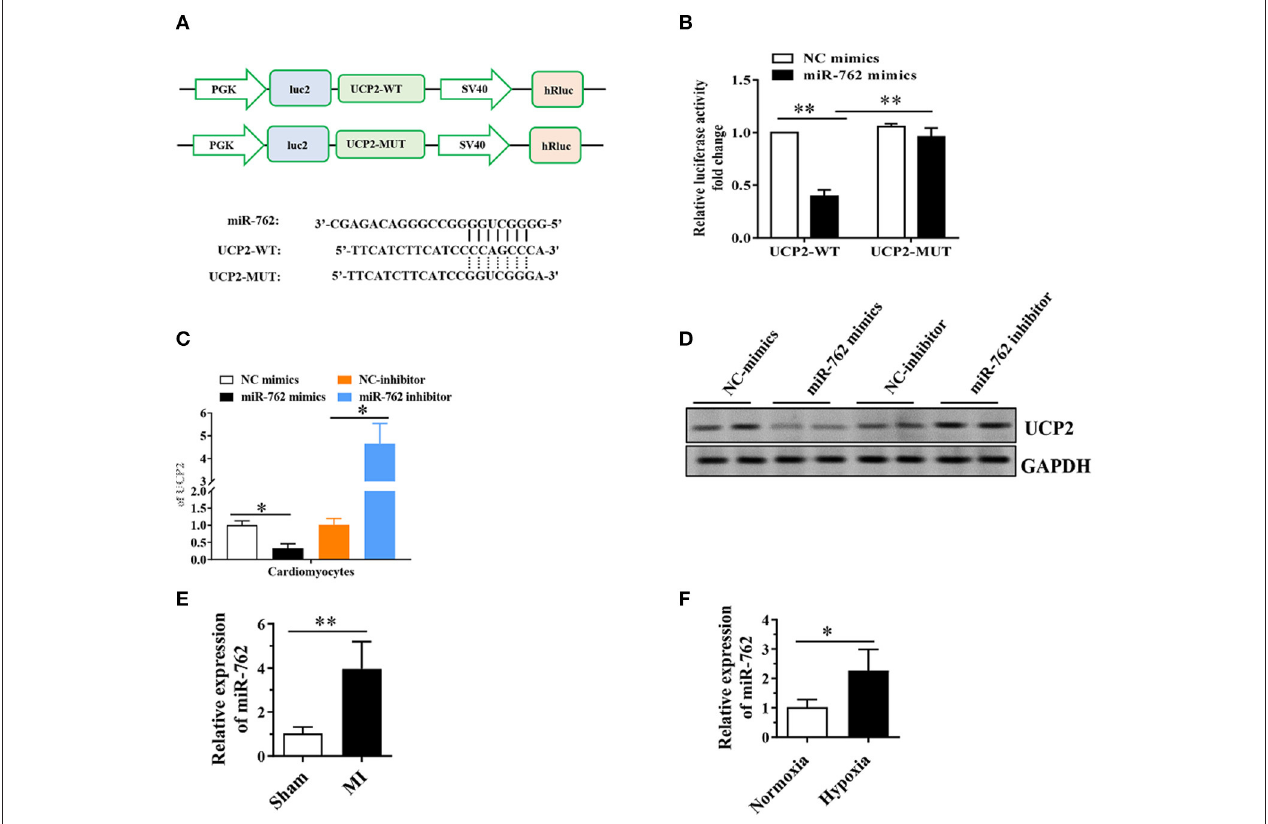
FIGURE 4 | MiR-762 directly targets UCP2. (A) The putative miR-762 binding sequence and the mutant sequence in the 3 ′ UTR of UCP2. (B) Luciferase reporter activities of vectors carrying luciferase gene and a fragment of UCP2 3 ′ UTR containing the wild-type and mutant binding sites of miR-762. (C) Quantitative real-time PCR was performed to detect the expression of UCP2 mRNA. (D) Western blot was used to detect the level of UCP2 protein. (E,F) MiR-762 was significantly up-regulated in mouse myocardial tissue after MI and NMCMs cells subjected to hypoxia. The results were presented as the mean ± SD, n = 6, * P < 0.05. ** P < 0.01. MI, myocardial